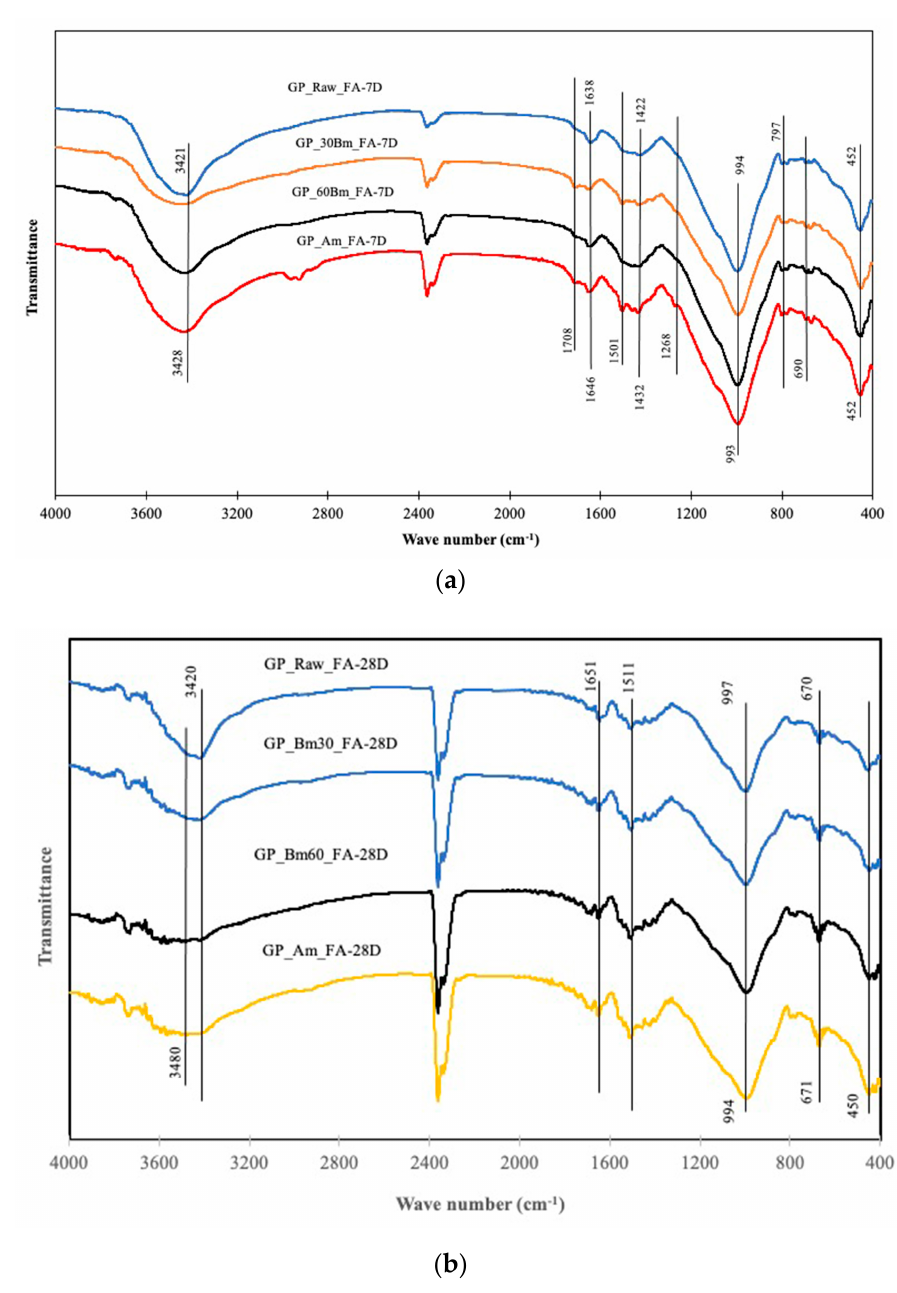
Figure 5. FTIR diagrams of the raw and milled fly-ash-based geopolymers cured for ( a ) 7 days and ( b ) 28 days.